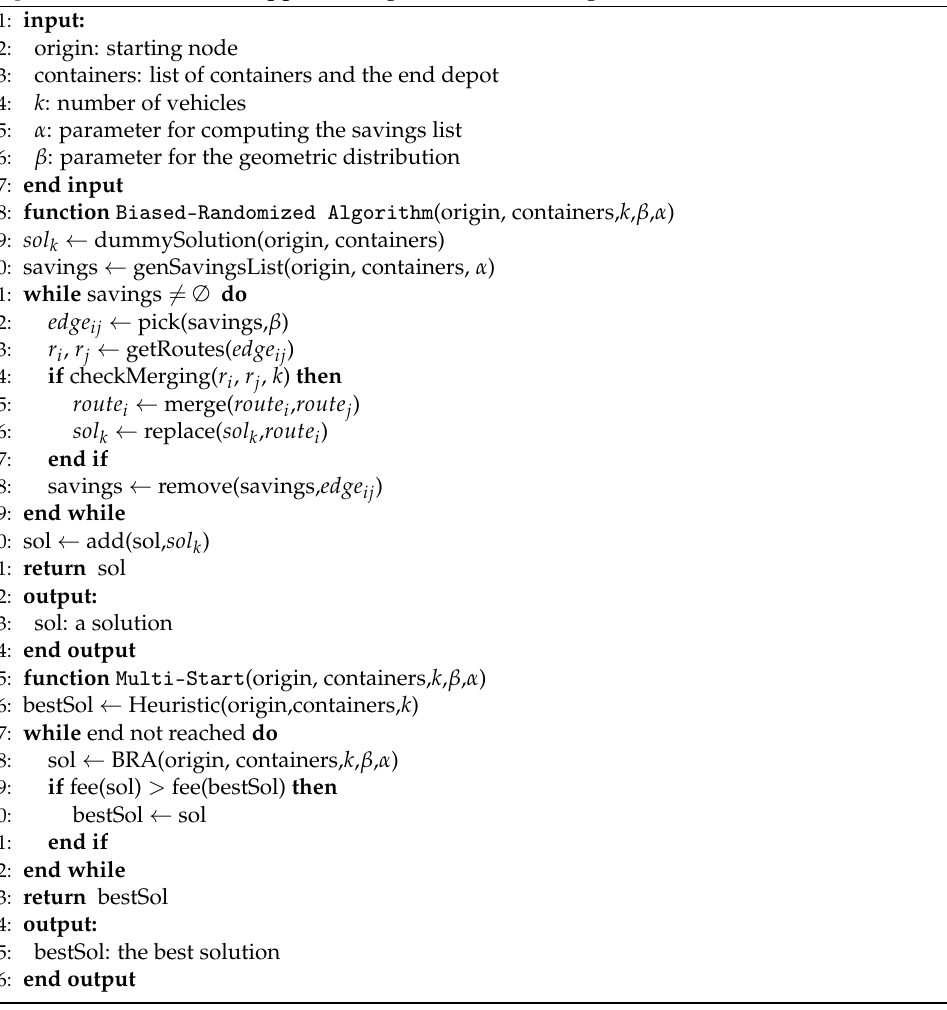
Algorithm 1 Multi-Start approach algorithm for solving a static TOP-MV